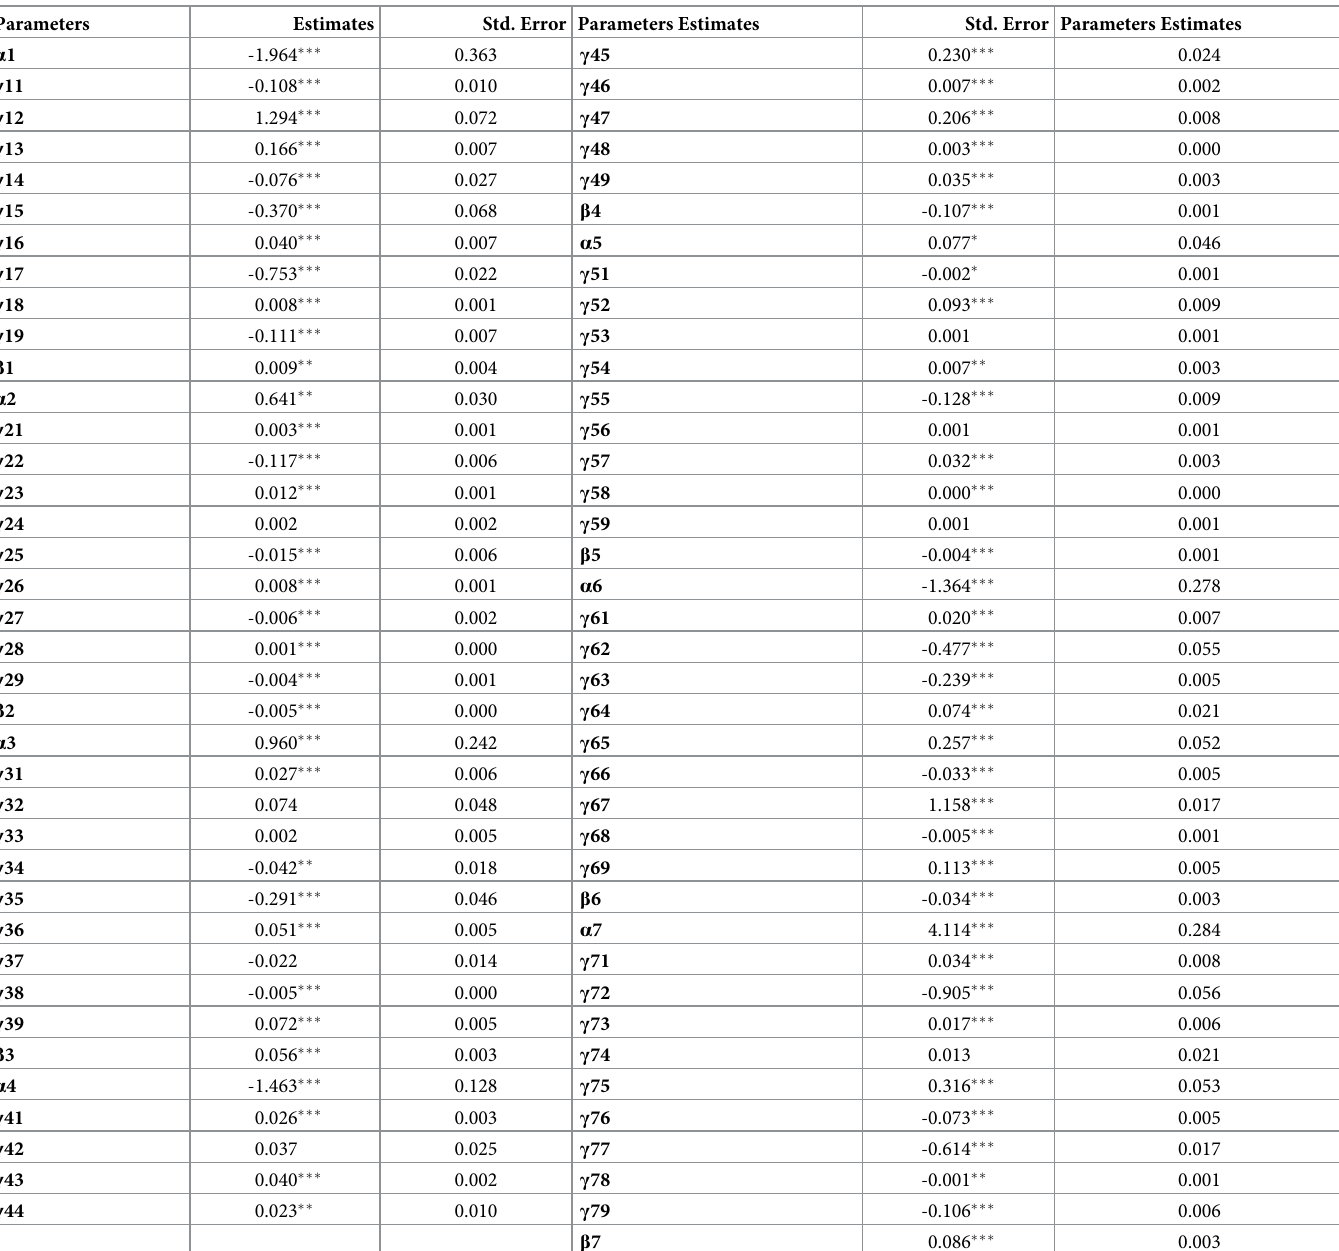
Table 4. LA-AIDS